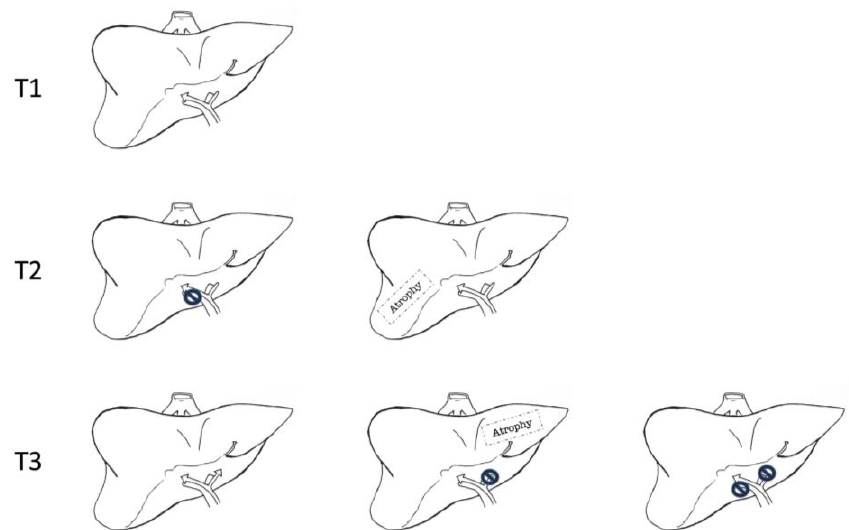
Figure 2. Blumgart T-staging system for hilar cholangiocarcinoma. T1 corresponds to a tumour involving biliary confluence with unilateral extension to second-order biliary radicles. T2 corresponds to a tumour involving biliary confluence with unilateral extension to second-order biliary radicles and ipsilateral portal vein involvement or ipsilateral hepatic atrophy. T3 corresponds to tumours involving biliary confluence with bilateral extension to second-order biliary radicles, unilateral extension to second-order biliary radicles with contralateral portal vein involvement, unilateral extension to second-order biliary radicles with contralateral hepatic lobar atrophy, or main or bilateral portal venous involvement.